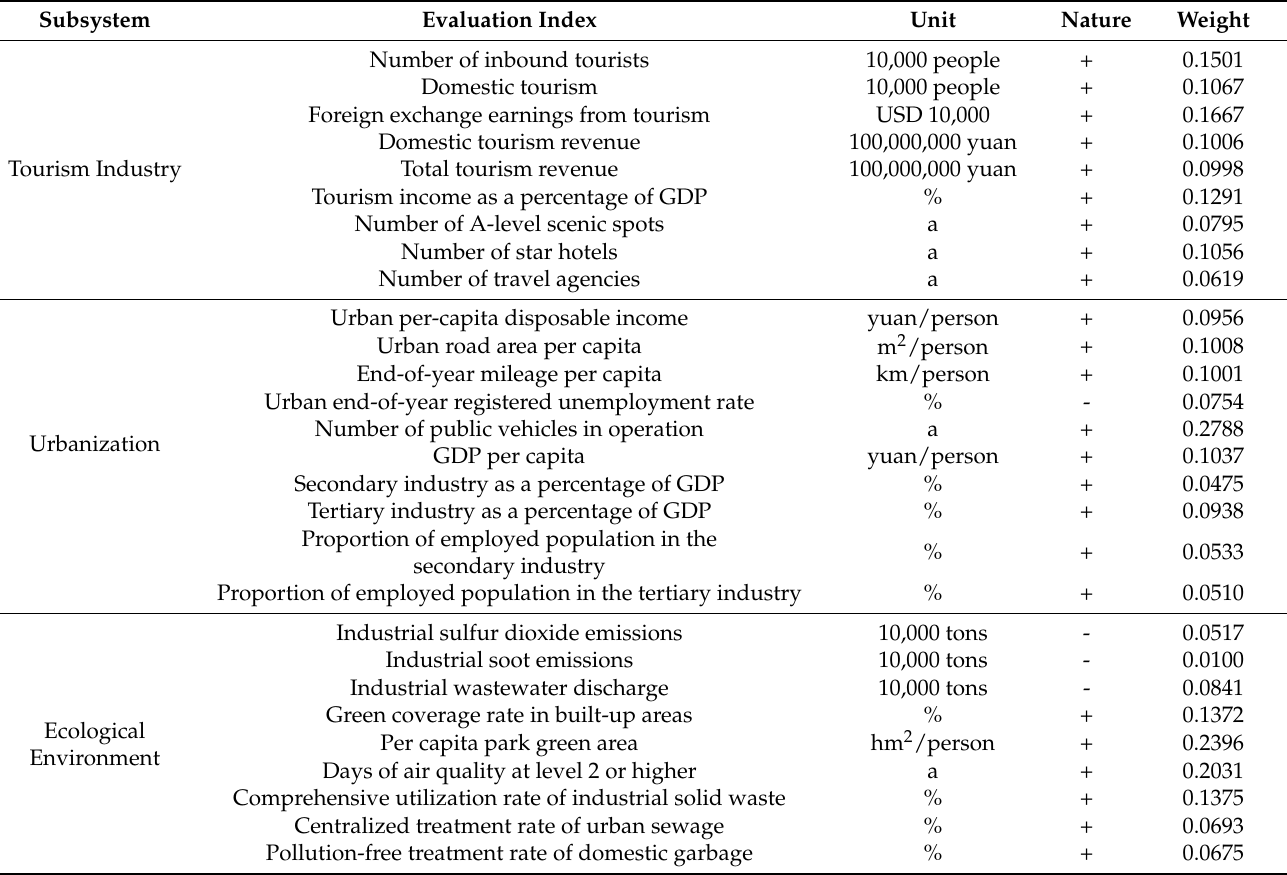
Table 1. Evaluation index system of the tourism–urbanization–ecological environment